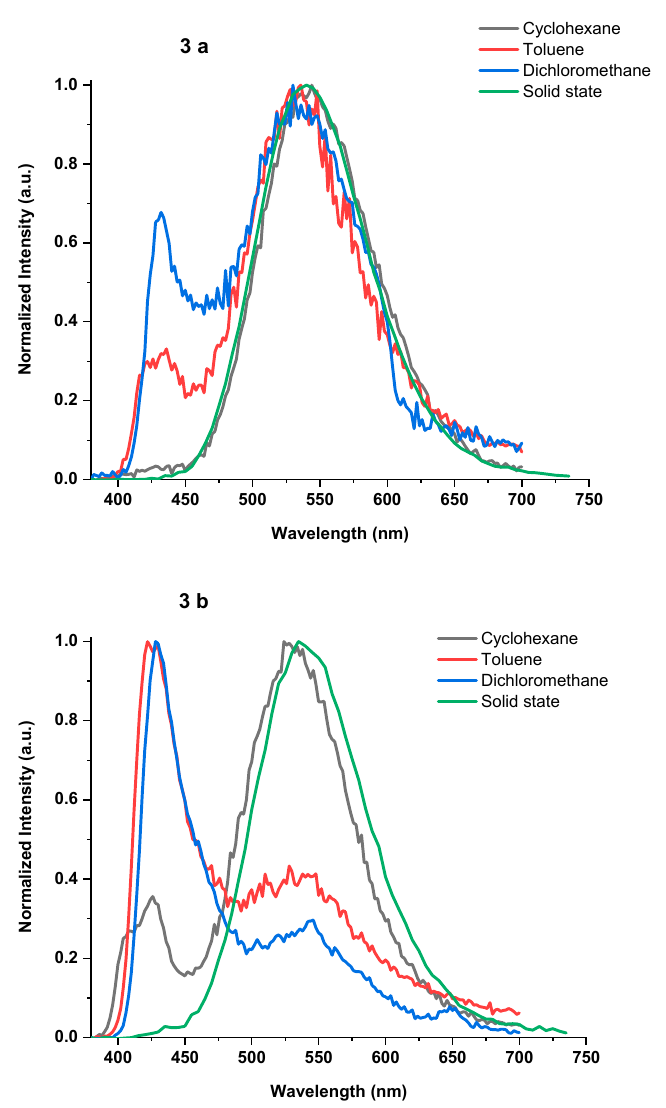
Figure 32. The delayed fluorescence spectra of polymers 3 a ( top ) and 3 b ( bottom ) in various solvents and solid state. Table 5. Results of multiexponential fitting obtained for delayed fluorescence kinetics of polymers 3 a,b at 540 nm in various deaerated solvents and the deaerated solid state ( λ ex = 375 nm).